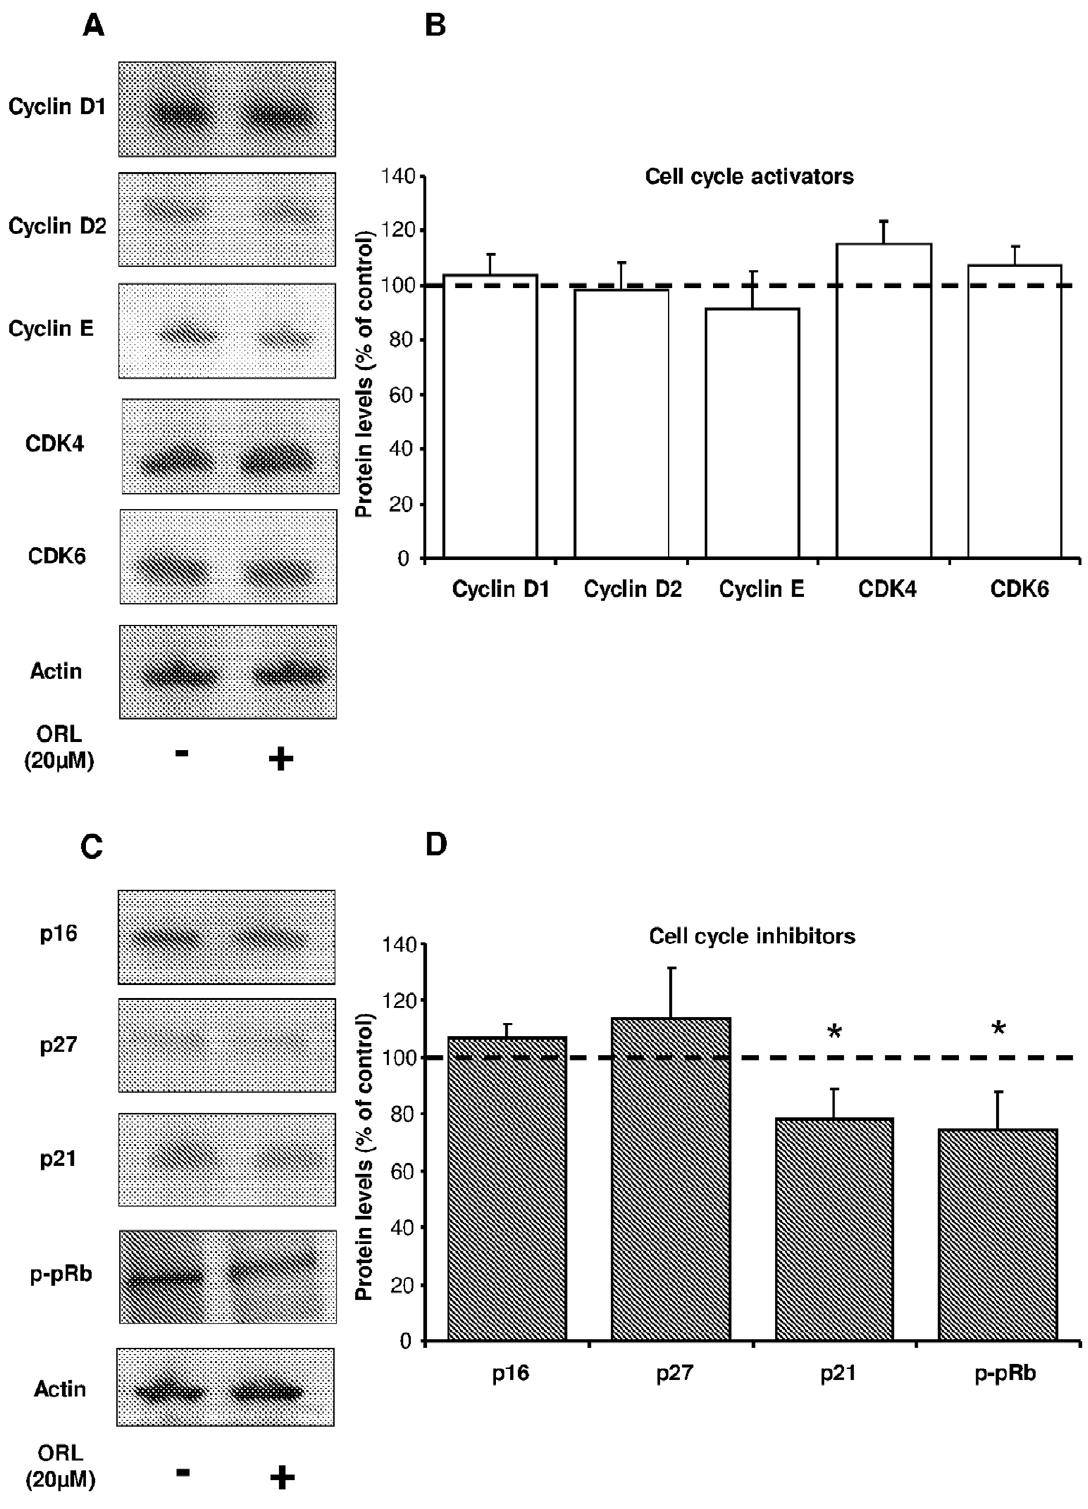
Figure 6. Effects of orlistat on cell cycle regulatory proteins in myeloma cells. Western blot analysis of cell cycle regulatory proteins from orlistat-treated myeloma cells. Cells were treated in the presence or absence of 20 m M orlistat for 24 hours before harvesting the cells, preparation of cell extracts and detection of proteins by specific antibodies. Representative immunoblot of cell cycle activators ( A ) and inhibitors ( C ). Quantification of the total data set expressed as percentage of control ( B, D ). Mean 6 SEM for 4–6 independent experiments. *p , 0.05 versus untreated cells.